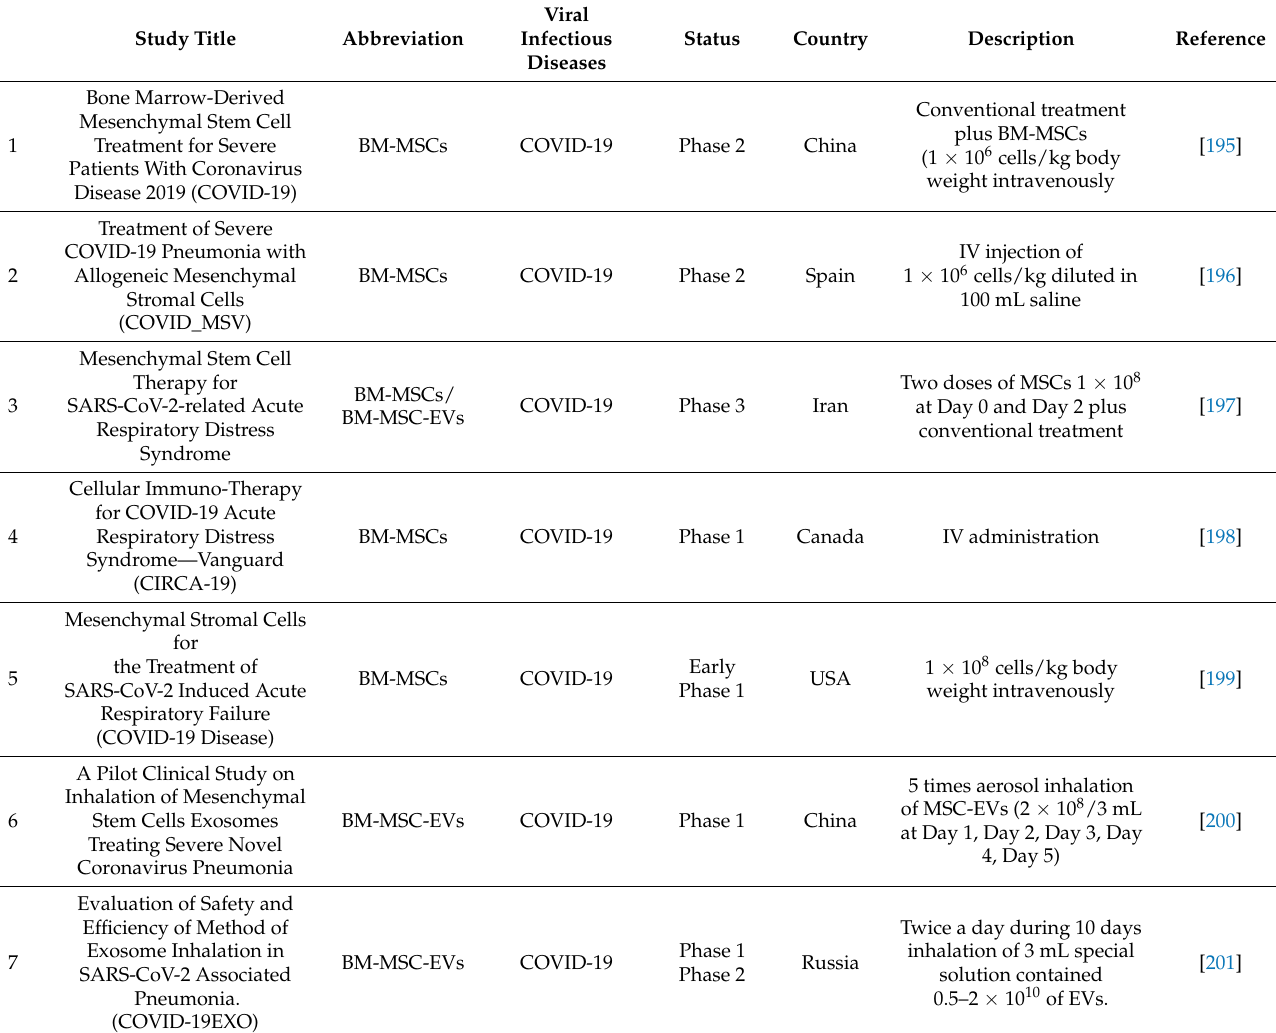
Table 3. MSCs and MSC-EVs based clinical trials of the viral infection